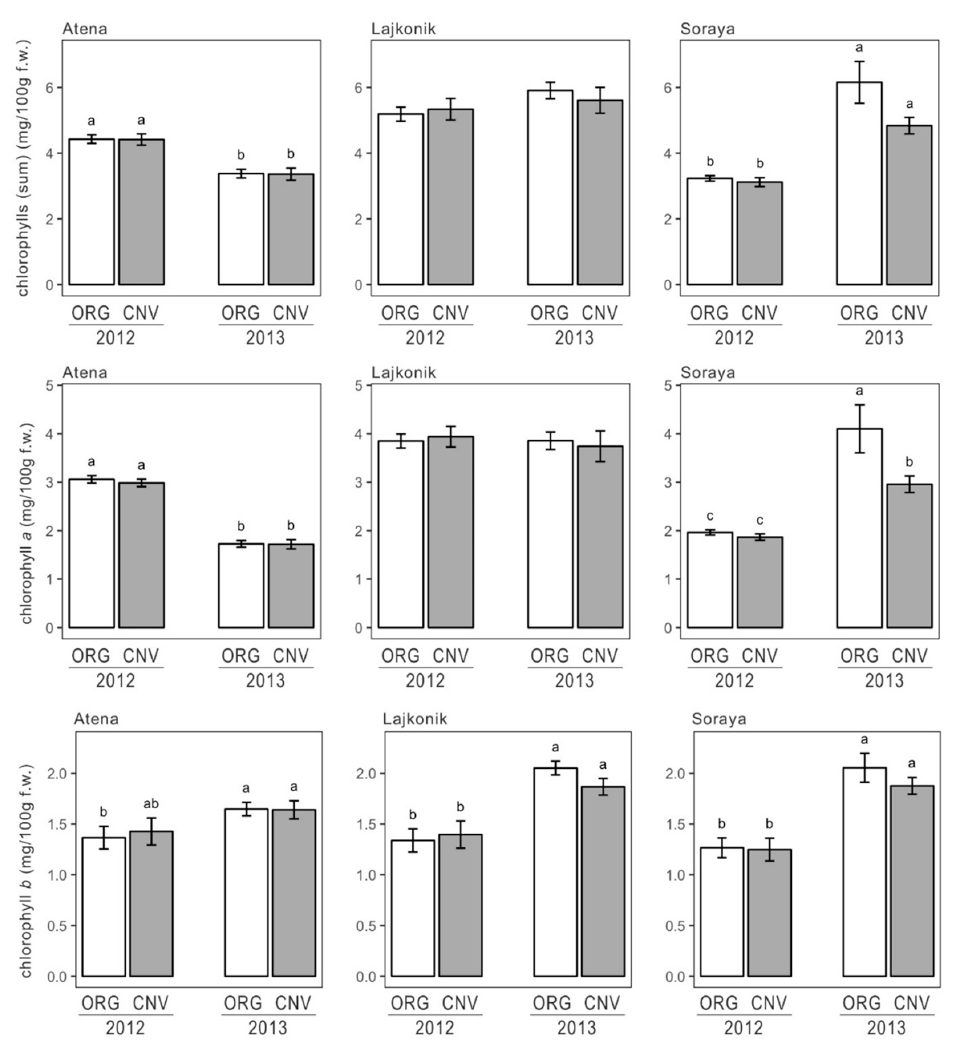
Figure 8. Chlorophylls (sum), chlorophyll a and chlorophyll b content in organic (ORG)